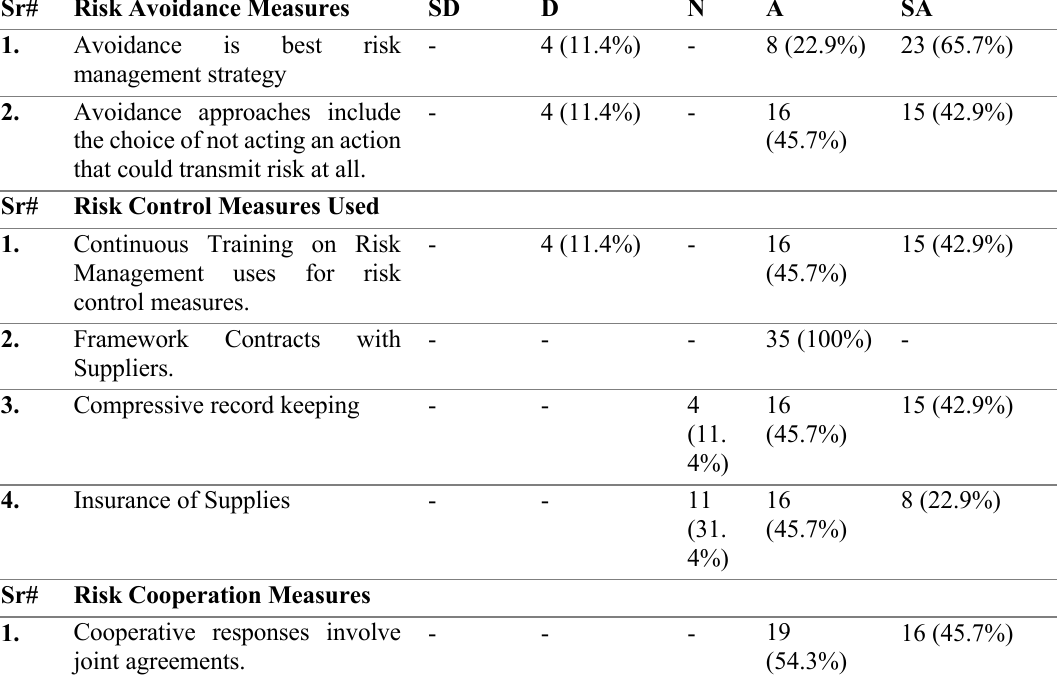
Table 4: Descriptive statistics of supply chain risks mitigations strategies used in the organization